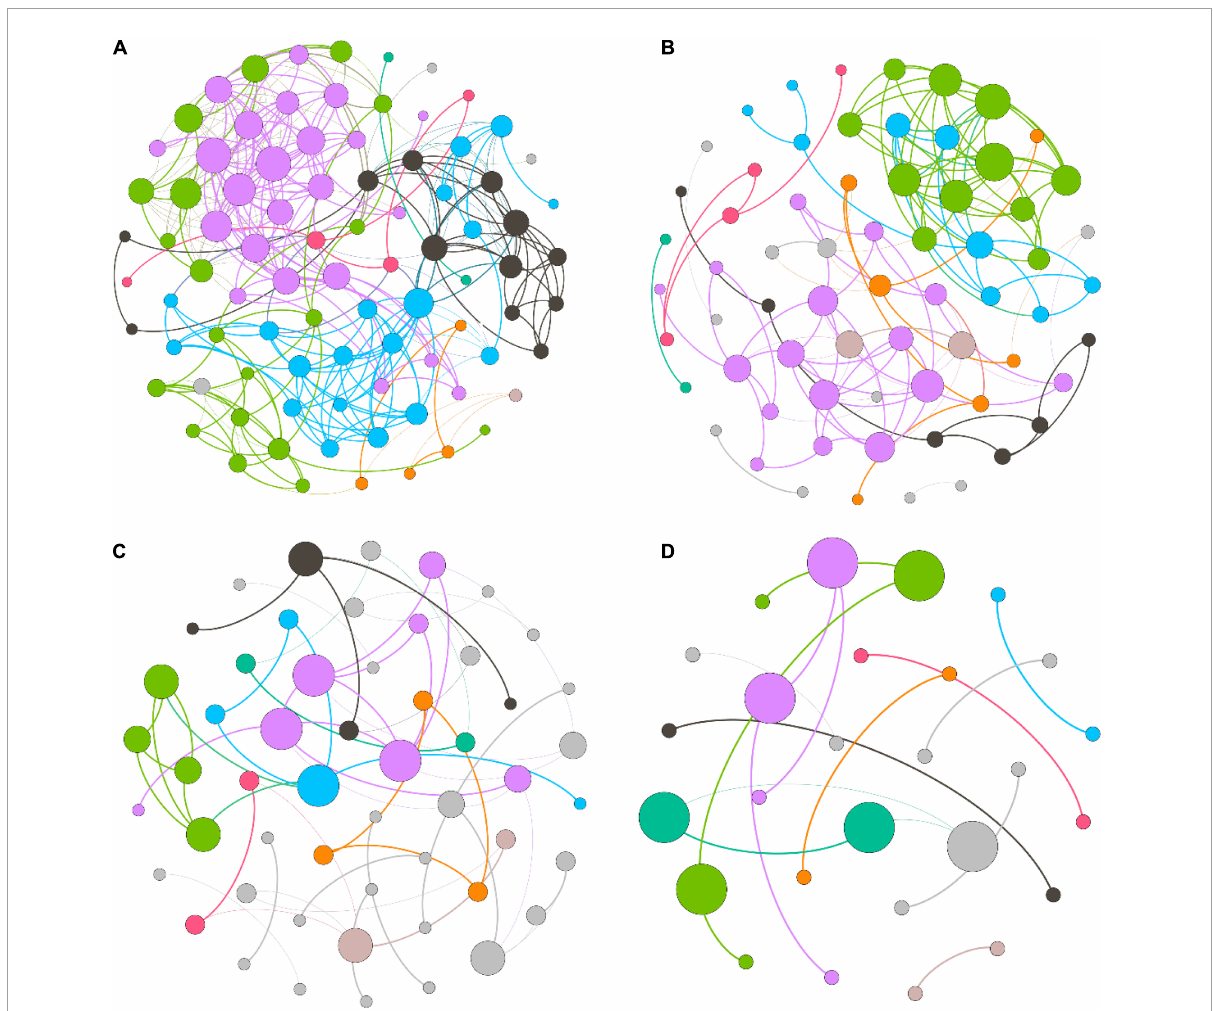
FIGURE7 Co-occurrence network of freshwater bacterial assemblages in different wetlands. (A) high N/P (LH), (B) low N/P (LL), (C) high N/P (HH), and (D) low N/P (HL). Each node represents a bacterial genus, the size of the node represents the degree, and nodes of the same color represent a network module. The connections between nodes represent significant relationships between genera ( r > 0.6 or r < –0.6, p < 0.05), and the thickness of the lines connecting nodes represent the size of the correlation coefficient.